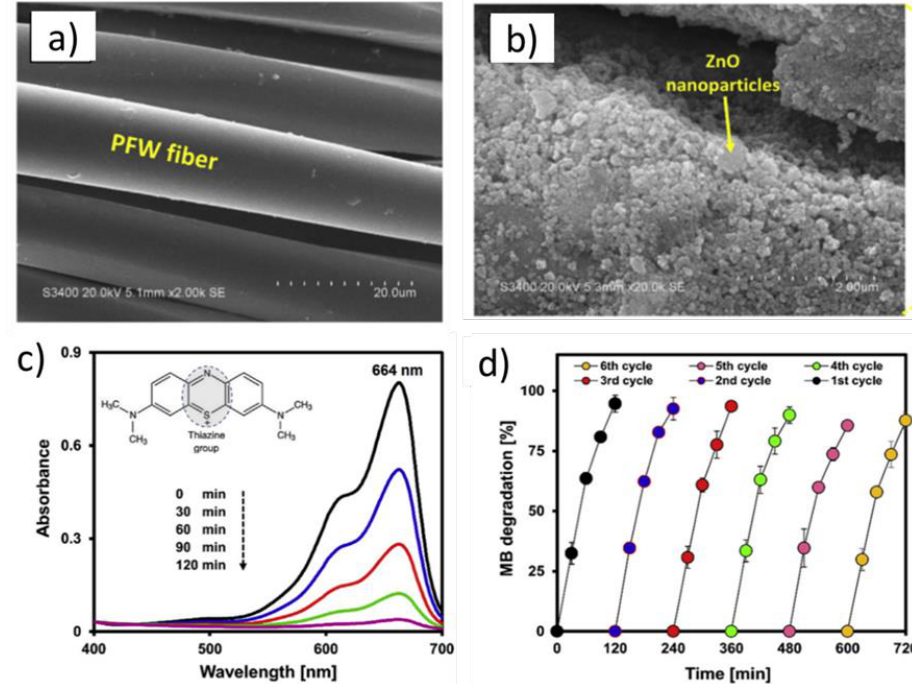
Figure 3. Untreated ( a ) and ZnO-coated ( b ) polyester fibers; UV-Vis absorption spectra of methylene blue solution in the course of photocatalysis by ZnO-coated polyester fabric ( c ); reusability test of ZnO-coated polyester fabric for methylene blue degradation ( d ). Reprinted with permission from [105]. Copyrights 2017 Elsevier.